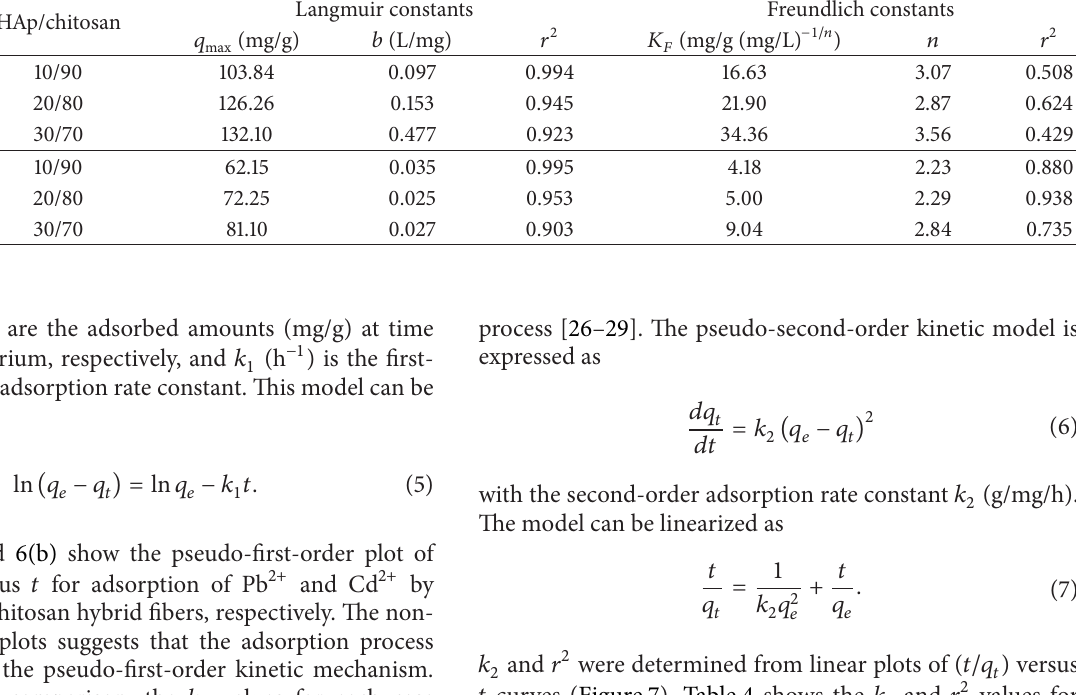
Table 2: Isotherm parameters for adsorption of Pb 2+ and Cd 2+ by HAp/chitosan hybrid fibers with different HAp contents. Langmuir Metal ions HAp/chitosan